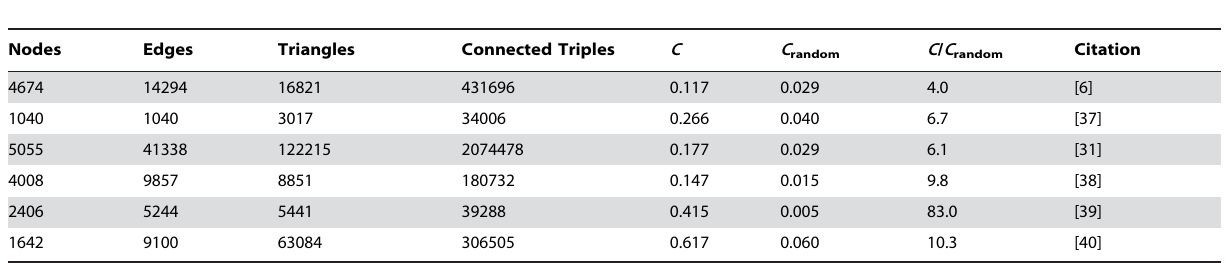
Table 1. Network measures, including C , the clustering coefficient of Saccharomyces cerevisiae protein interaction networks.